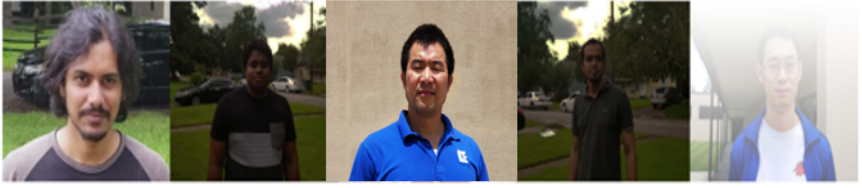
Figure 1. Sample face images of LUDB [1] used for FR experiment.